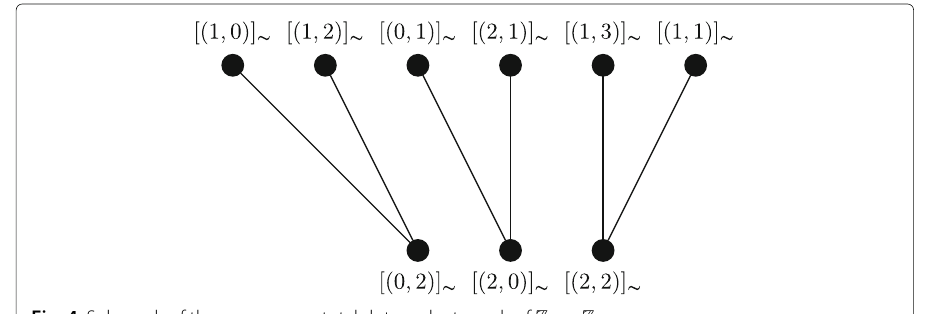
Fig. 4 Subgraph of the congruence total dot product graph of Z 4 × Z